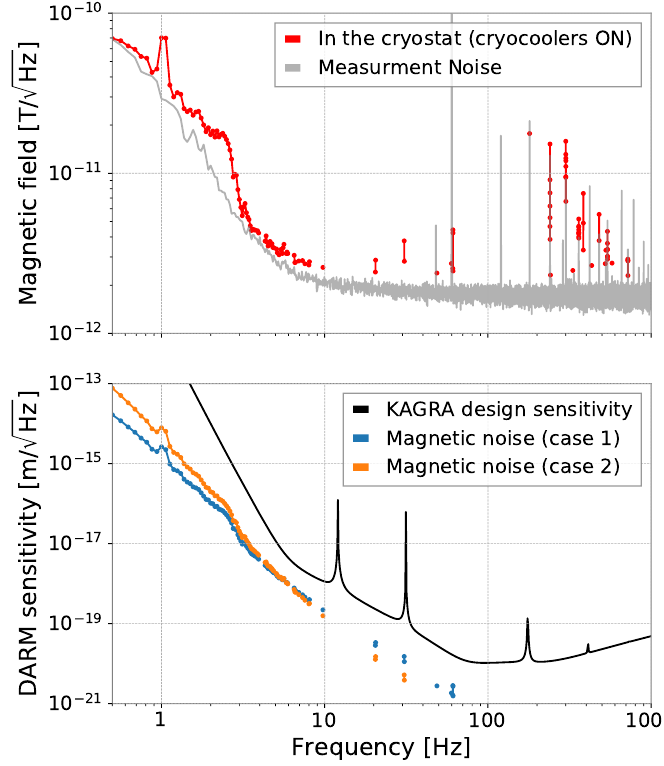
Figure 15. ( Top ) Magnetic field measured in a cryostat for the ETMX with cryocoolers. The gray line shows the measurement limit, including the sensor and ADC noises. ( Bottom ) Expected magnetic noise in the DARM sensitivity of KAGRA, calculated using the magnetic field in the top plot and the coupling functions evaluated for LIGO (blue) and Virgo